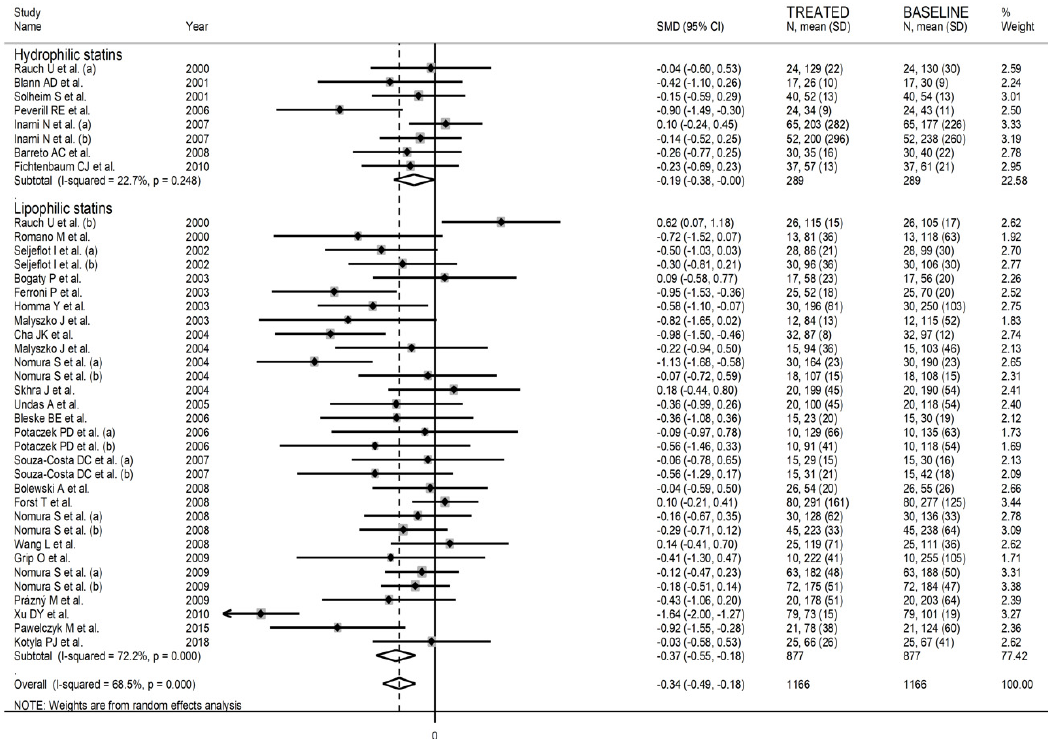
Figure 5. Forest plot of P-Selectin concentrations before and after statin treatment according to statin class (hydrophilic or lipophilic).